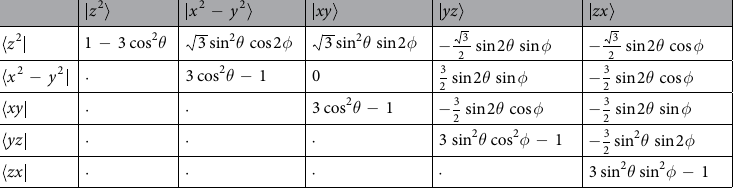
Table 1. Angular part of the matrix ∆ = Ψ azimuthal angles of the spin direction, respectively. Because this is a Hermitian matrix, the off-diagonal components below the diagonal are